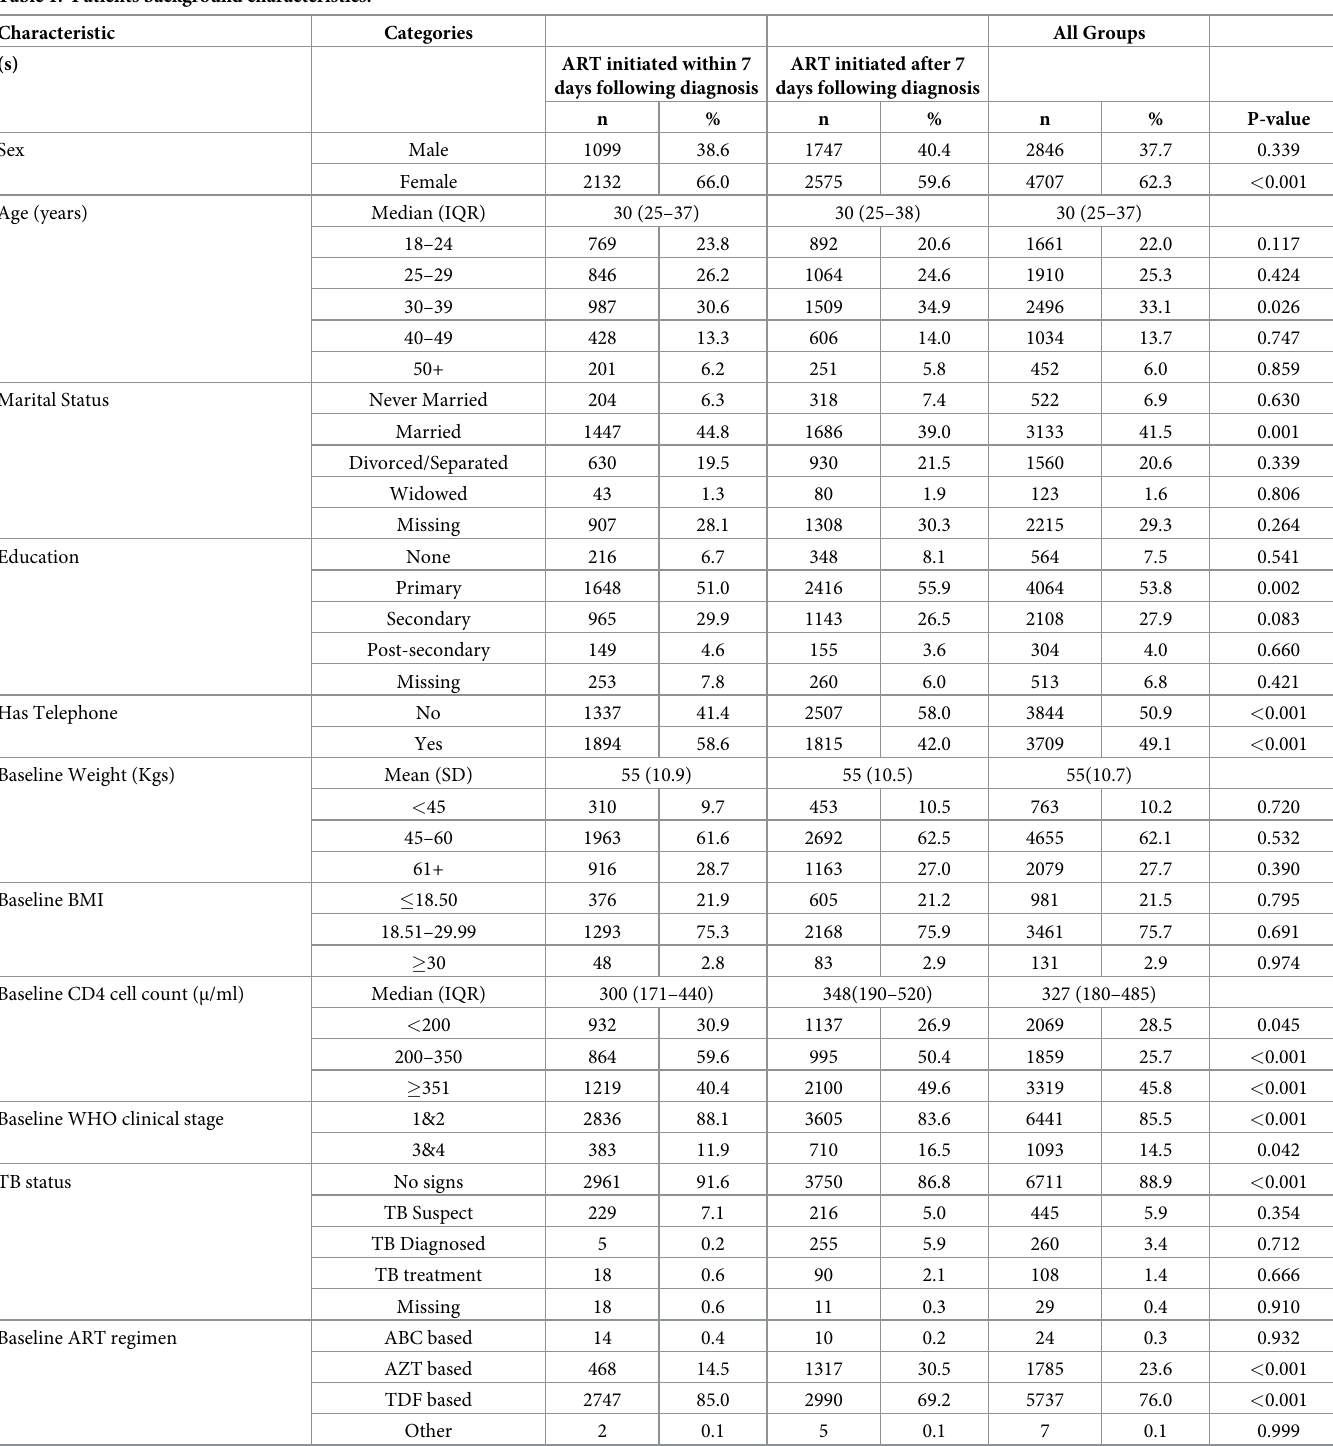
Table 1. Patients background